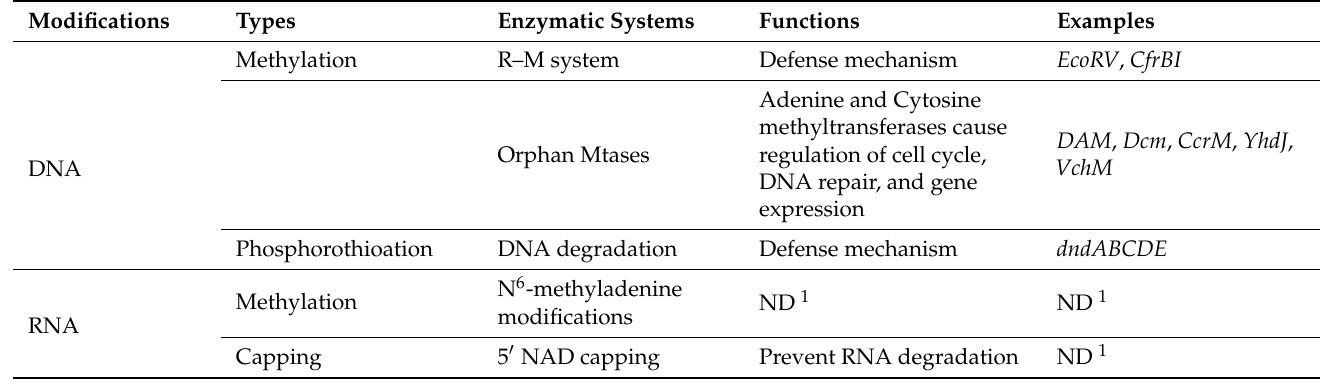
Table 1. Overview of bacterial epigenetics through DNA and RNA